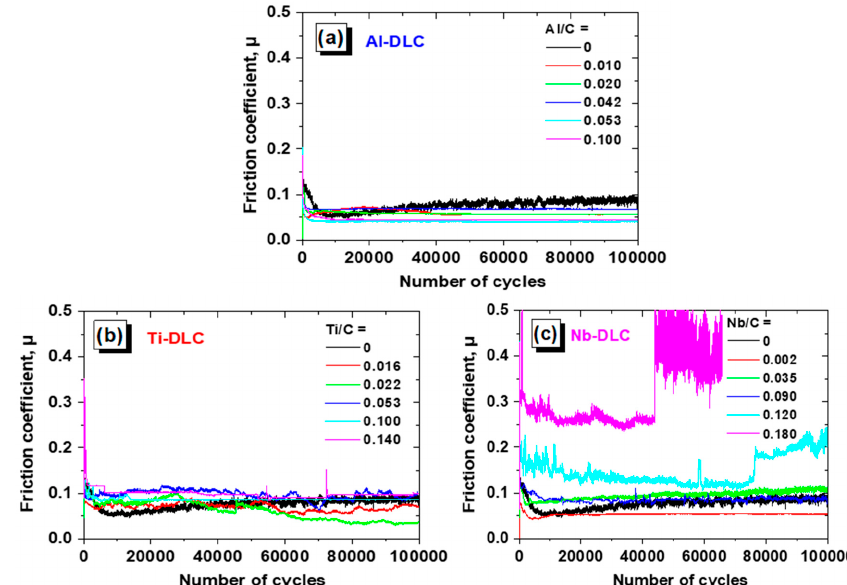
Figure 11. Friction coefficient as a function of the number of rotations in the ball-on-disc tests for ( a ) Al-DLC films, ( b ) Ti-DLC, and ( c ) Nb-DLC. ( a ) Al-DLC films, ( b ) Ti-DLC, and ( c )